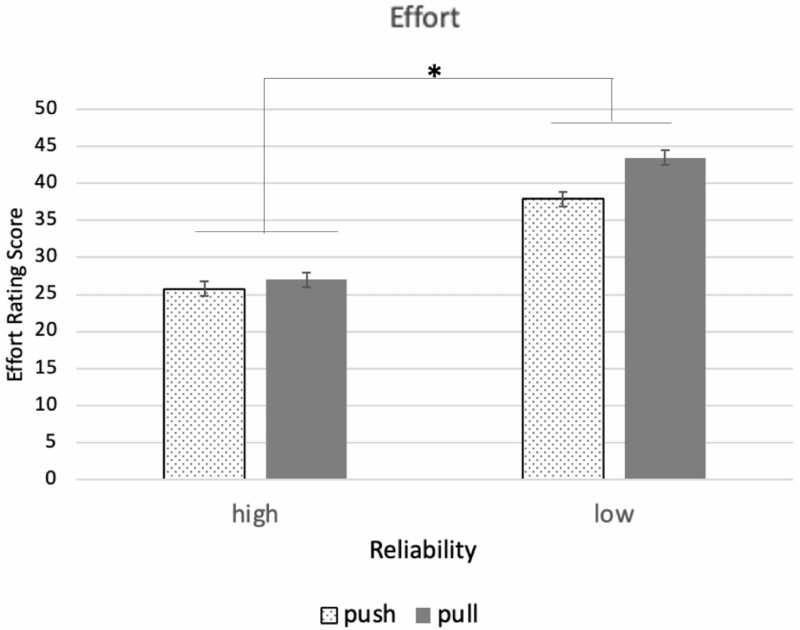
Figure 6. Effort measured by NASA/TLX in all conditions (* p < 0.05) [error bars indicate standard errors].